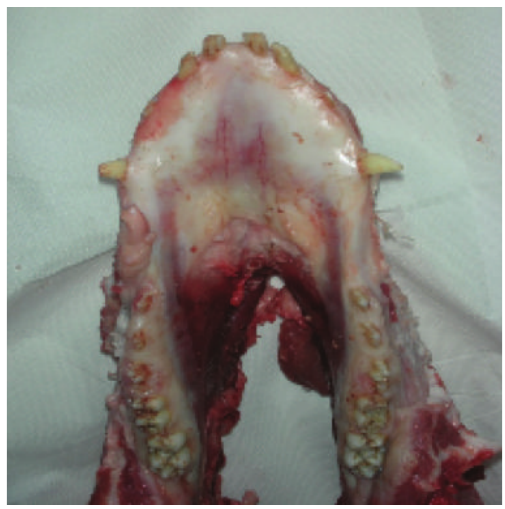
Figure 1: One of the specimens used for the